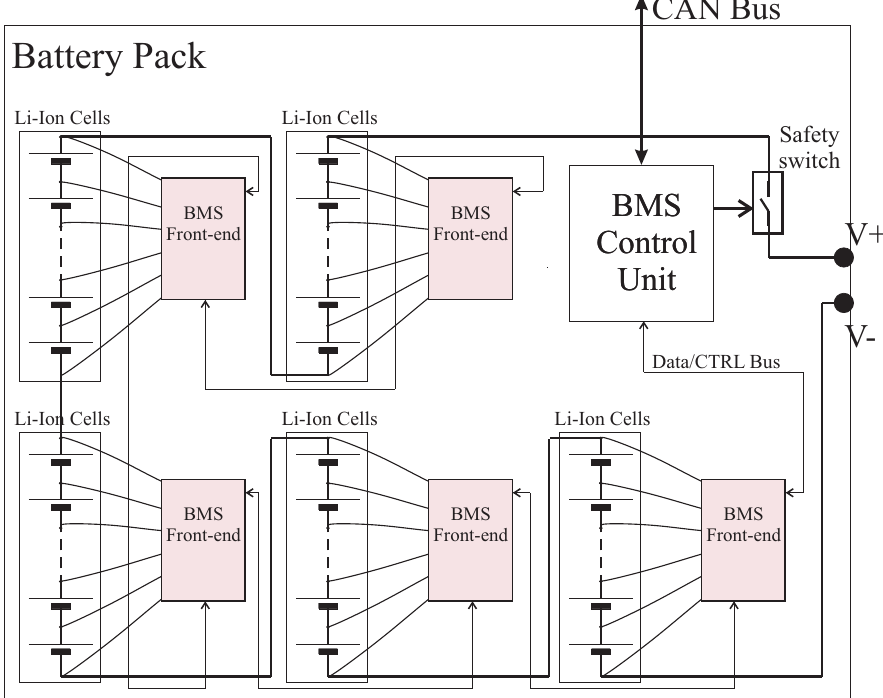
Figure 1. Architecture of a battery management system (BMS) for EV/HEV